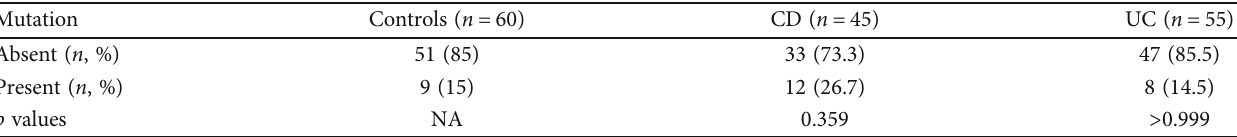
(a) FMF-related mutation frequency in the MEFV gene